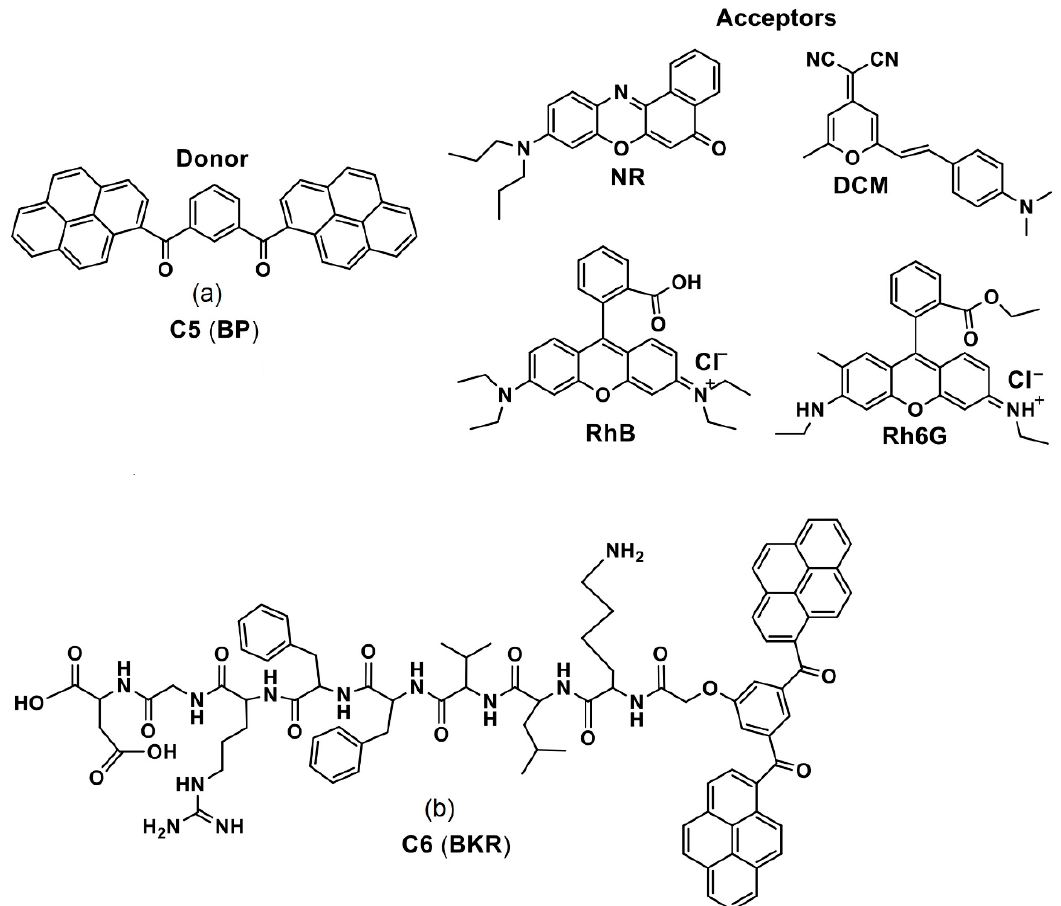
Figure 4. ( a , b ) C5 and C6 are the chemdraw structures of bis-pyrene donor (along with acceptors used) and bis-pyrene-conjugated peptide, respectively. (Note: the original representation or numbering of the molecules were provided in the brackets along with respective reference numbers).